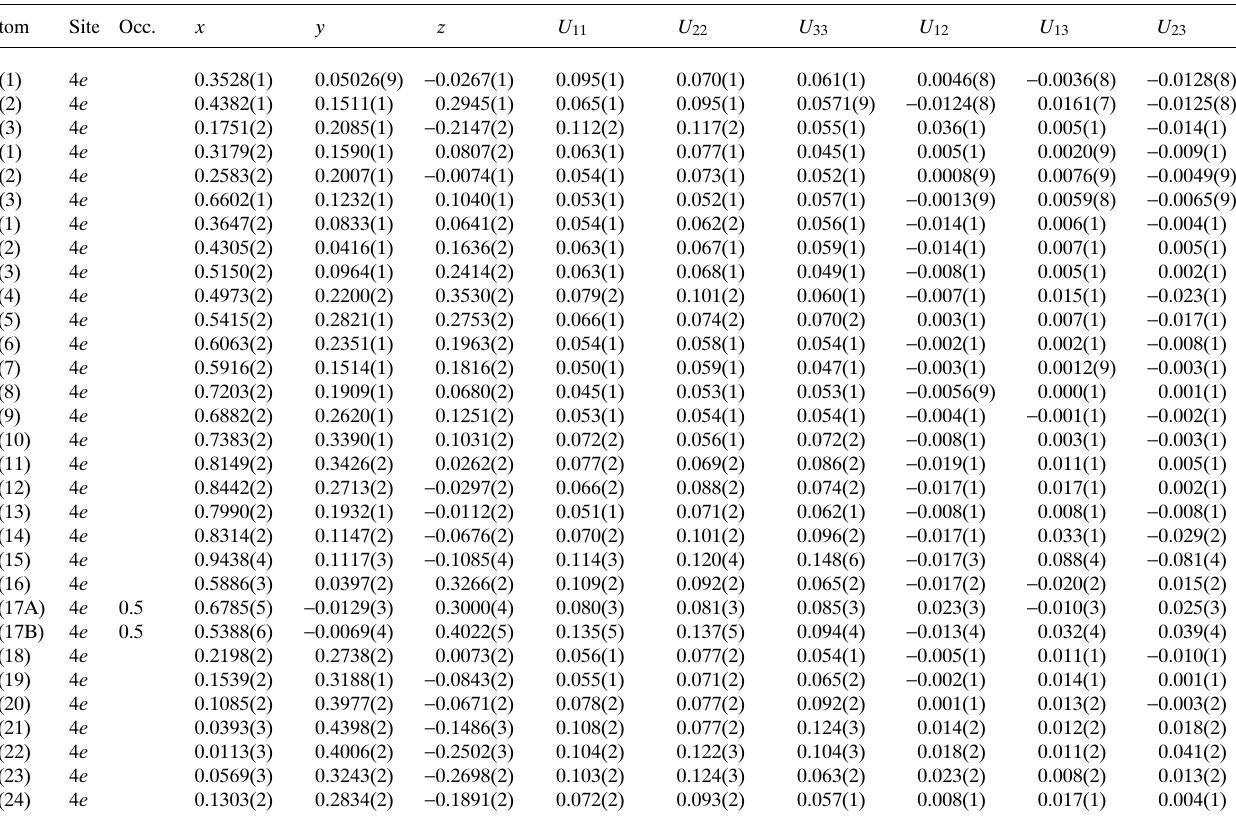
Table 3. Atomic coordinates and displacement parameters (in Å 2 ) .